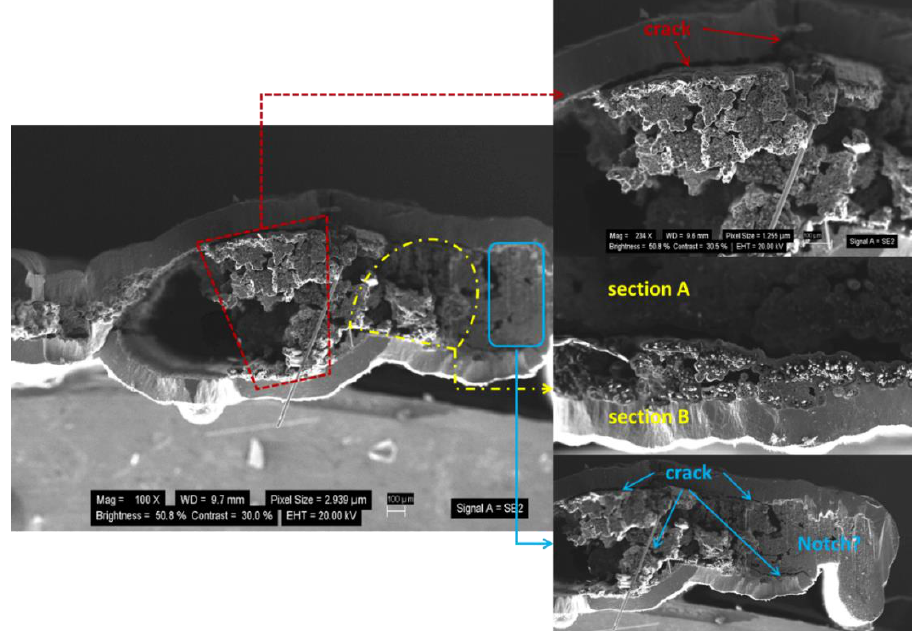
Figure 7. Fracture morphologies of sample NC_2.